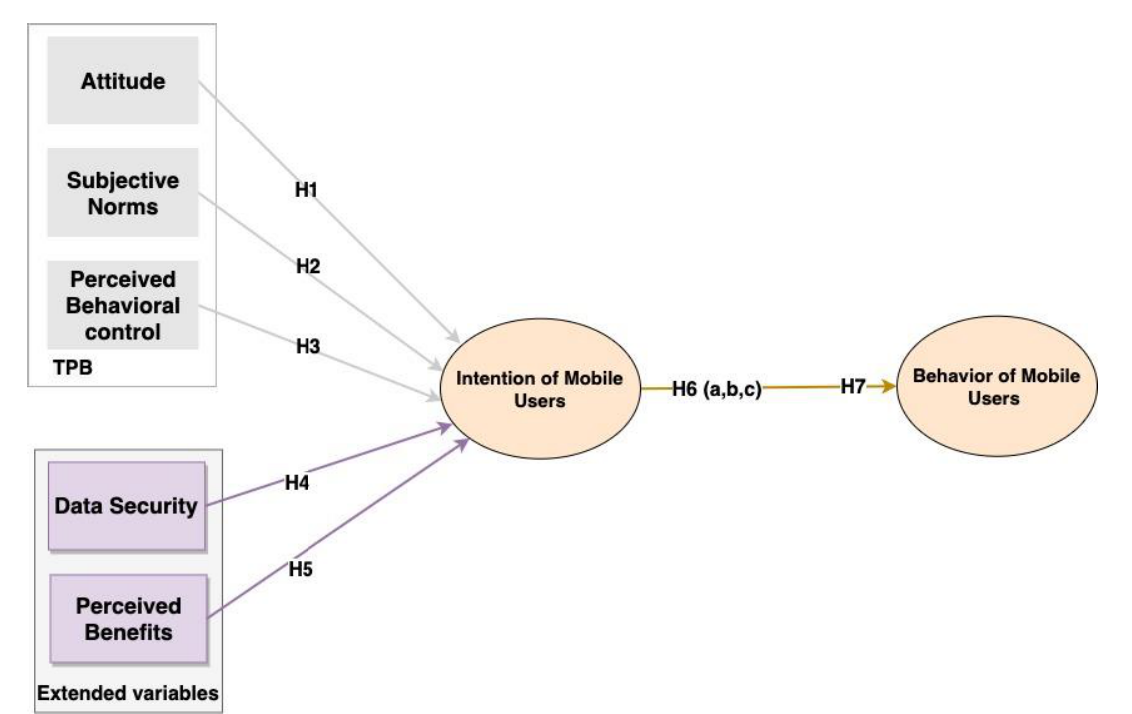
Figure 1. Conceptual model with hypotheses.